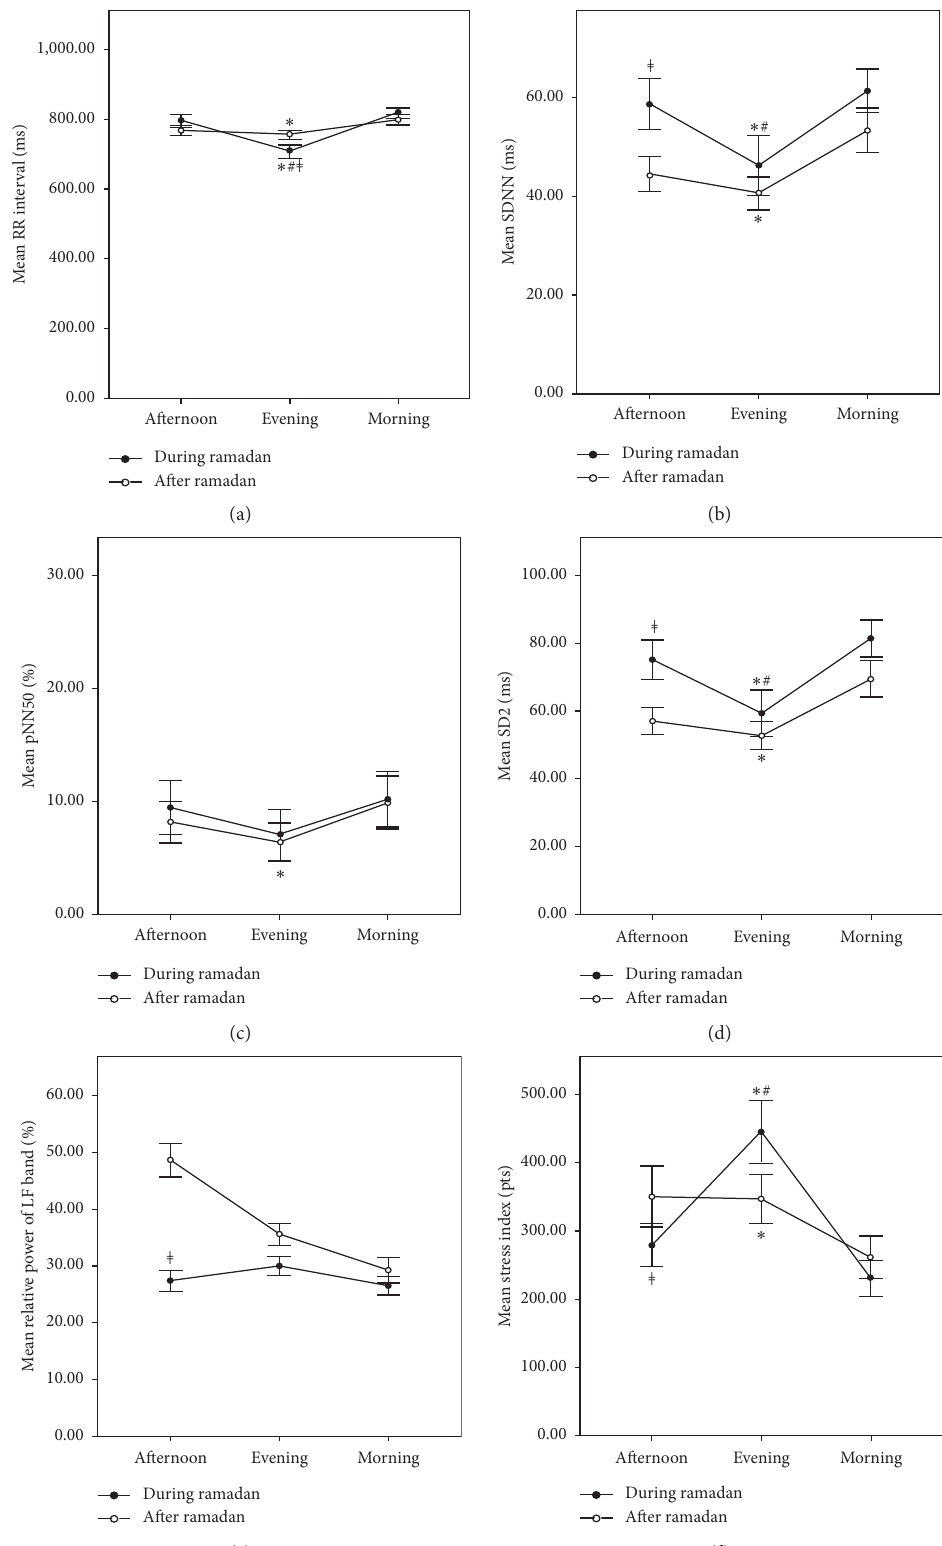
Figure 1: Variation of heart rate variability parameters significantly affected by Ramadan fasting. Graph showing variation of heart rate variability parameters during and after Ramadan, which have been significantly affected in fasting condition: (a) R-R interval (ms), (b) SDNN (ms), (c) pNN50 (%), (d) SD2 (ms), (e) relative power of LF band (%), and (f) stress index (pts). ∗ Statistically different compared to morning period of the same day, # statistically different to afternoon period of the same day, ≠ significantly different compared to same period of non-fasting